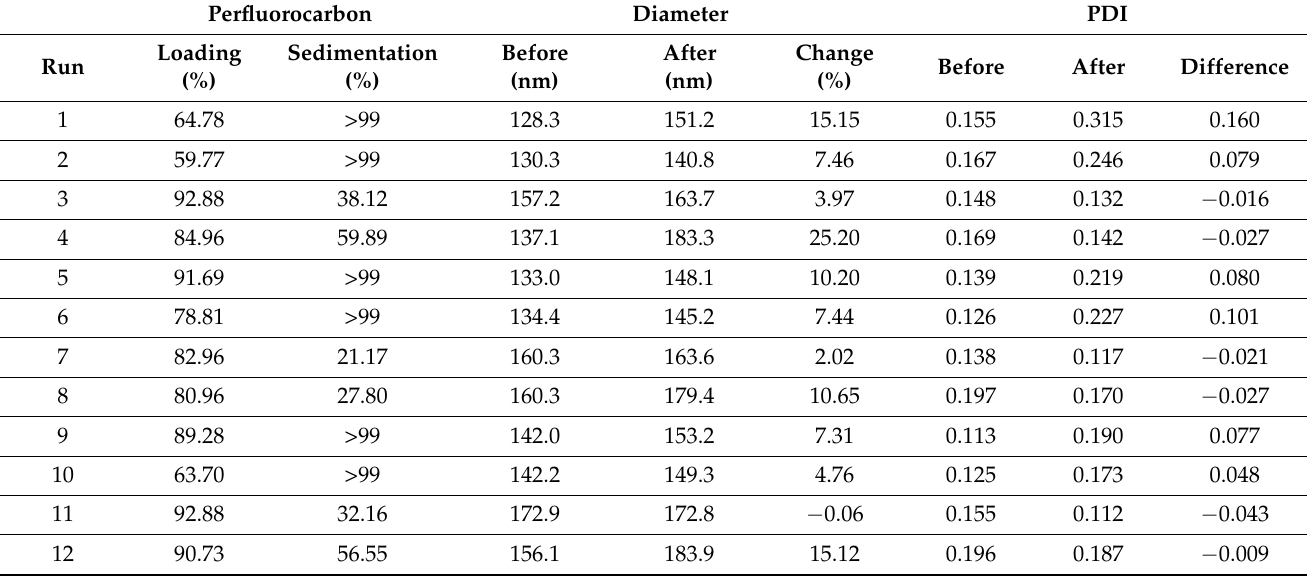
Table 8. Nanoemulsion sedimentation analyses. Nanoemulsion diameter, PDI, and perfluorocarbon content were assessed in nanoemulsions before and after resuspension of any sedimentation. These measurements were used to calculate nanoemulsion percent diameter change upon resuspension, change in PDI upon resuspension, perfluorocarbon loading of resuspended nanoemulsion, and percent perfluorocarbon sedimentation in nanoemulsion prior to resuspension. Perfluorocarbon sedimentation of >99% indicates that perfluorocarbon could not be detected in the NMR sample collected prior to nanoemulsion resuspension, suggesting that all perfluorocarbon had